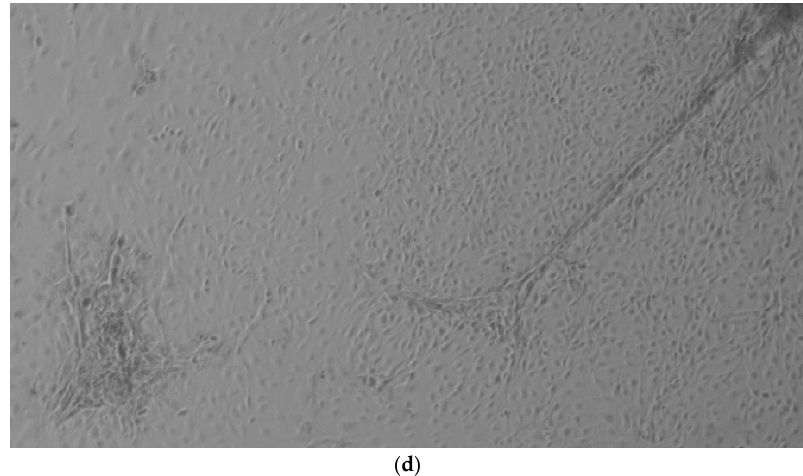
Figure 1. HiPS stem cells are coated as EB ((embryoid bodies) mandatory step before di ff erentiating into osteoblasts), when they reach confluence; i.e., a situation in which they no longer have space to grow They then move on to the phase of di ff erentiation in the osteoblastic sense, thus changing the type of medium. ( a ) CTR2#6 P19 (one of four clones) reached confluence (70–80%) on day 12 (magnification 10 × , plates 70,000 cells); ( b ) CTR4#5 P20 reached confluence (70–80%) on day 21 (magnification 10 × , plates 70,000 cells); ( c ), CTR8#14 P12 + RA reached the confluence (70–80%) on day 21 (magnification 10 × , plates 70,000 cells); ( d ) CTR8#14 P12 - RA reached confluence (70–80%) on day 6 (magnification 10 × , plates 70,000 cells).